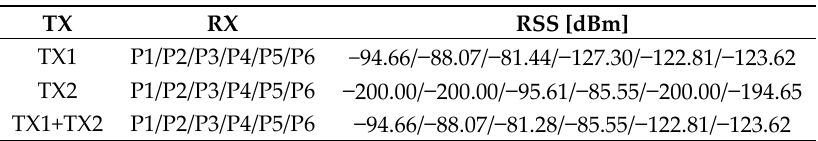
Table 3. Received Signal